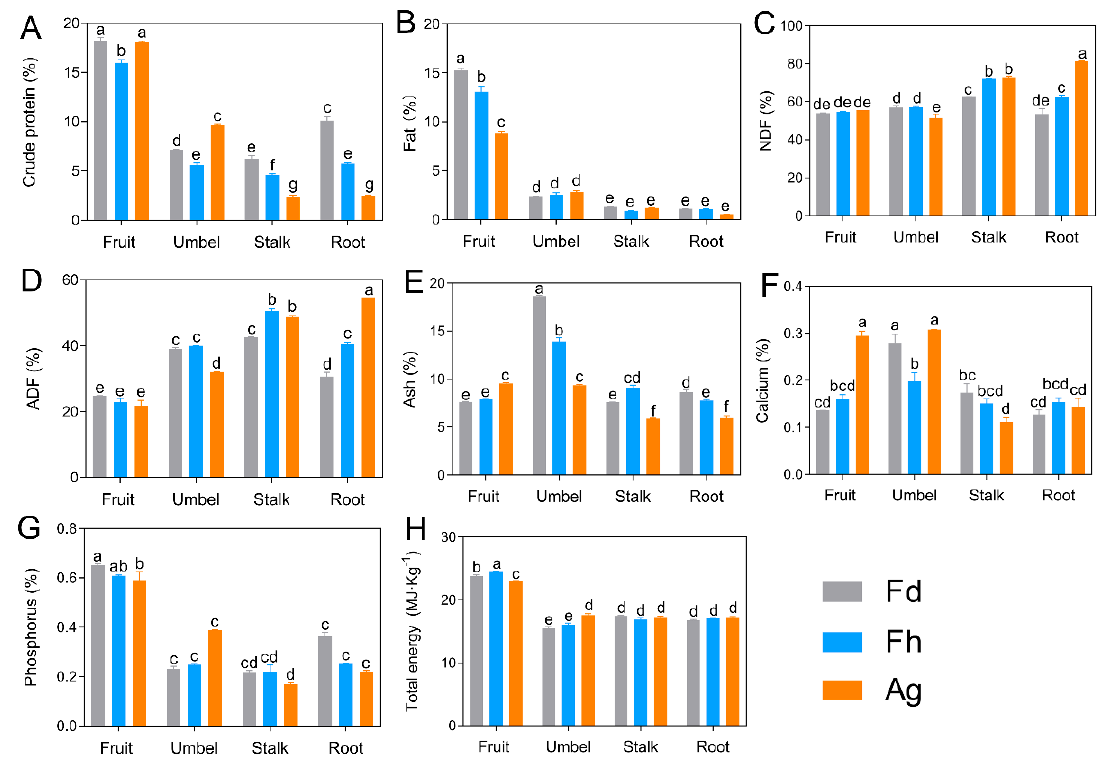
Figure 2. Nutritional composition ( A – G ) and total energy ( H ) of fruits, umbels, stalks, and roots from three Apiaceae species. Acid detergent fiber (ADF) and neutral detergent fiber (NDF); Foeniculum vulgare “Dwarf” (Fd), F. vulgare “High” (Fh), Anethum graveolens (Ag). Different letters indicate significant differences ( p < 0.05).